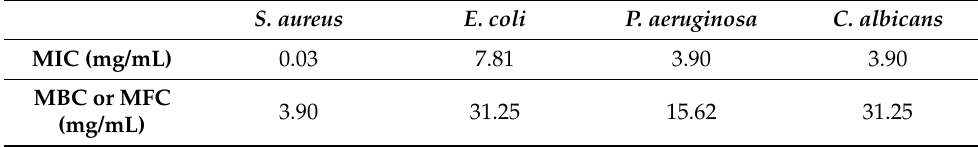
Table 3. Minimal inhibitory concentration (MIC), minimal bactericidal concentration (MBC), and minimum fungicidal concentration (MFC) of the tamarind seed coat (TS) extract against S. aureus (A), E. coli (B), P. aeruginosa (C), and C. albicans (D) were defined. Interestingly, the lowest MIC and MBC to S. aureus ; 0.03 and 3.90 mg/mL (A), manifested the potent activity of TS